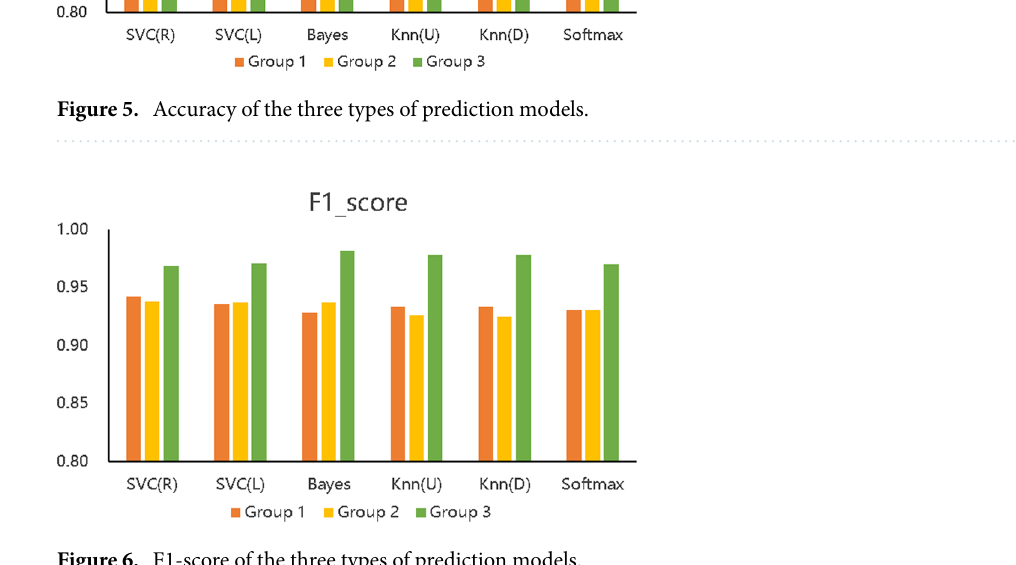
Figure 6. F1-score of the three types of prediction